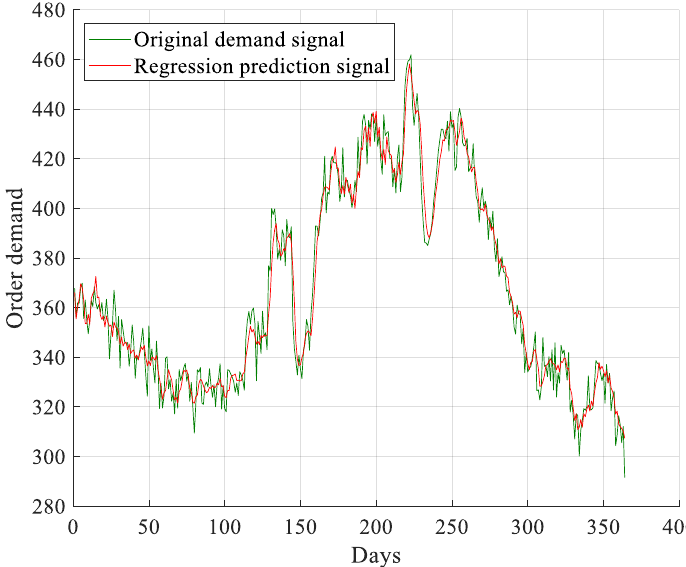
Figure 9. Regression forecast of original demand signal .